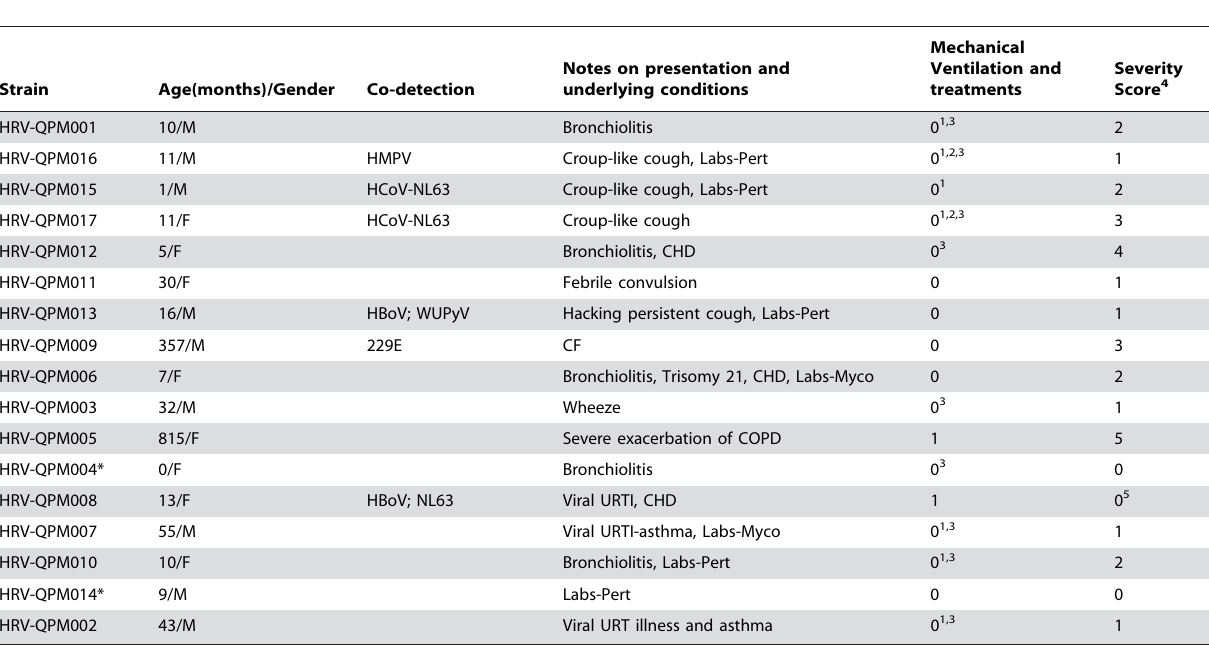
Table 2. HRV-QPM detections and association of co-morbidities and severity of respiratory illness upon